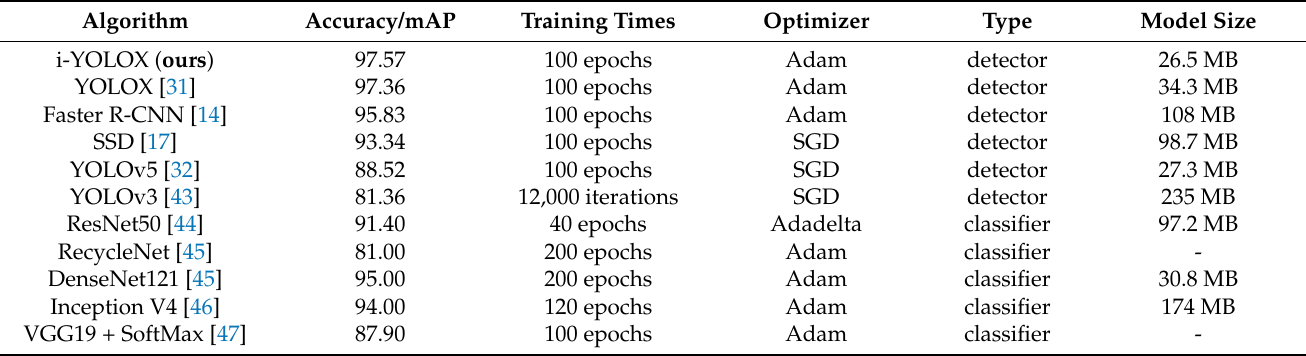
Table 6. Comparison with other detection and classification